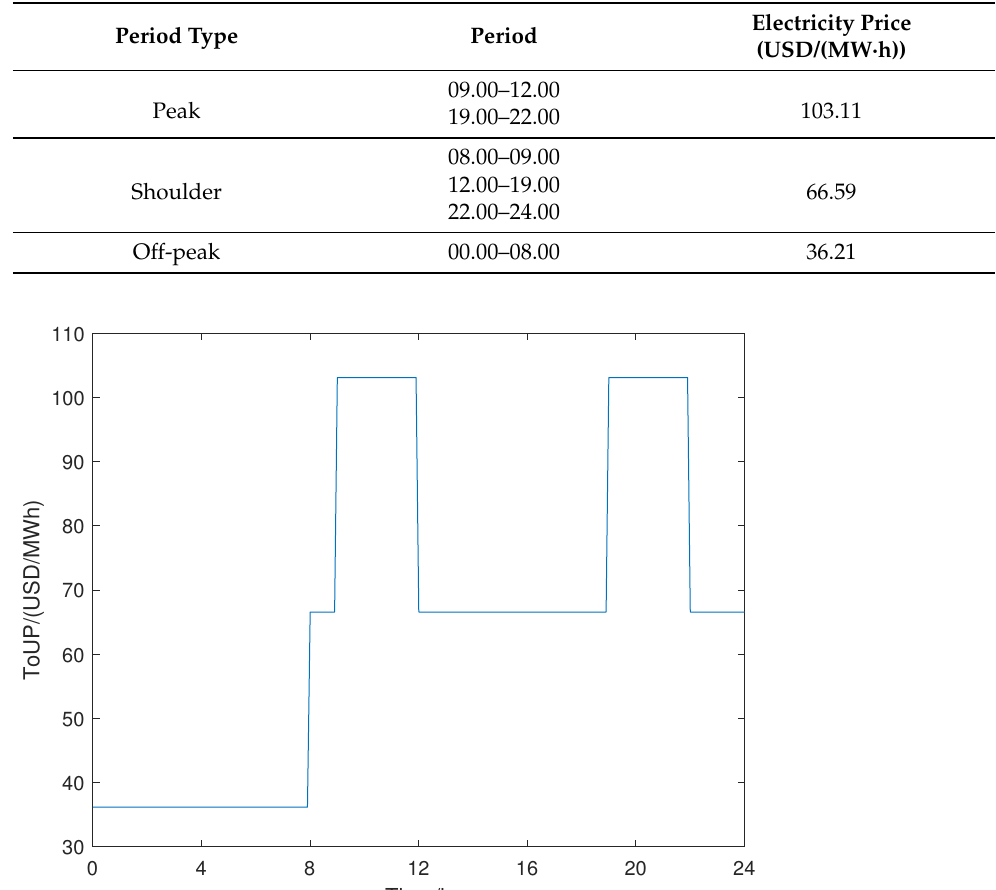
Table 1. Time-of-use pricing.